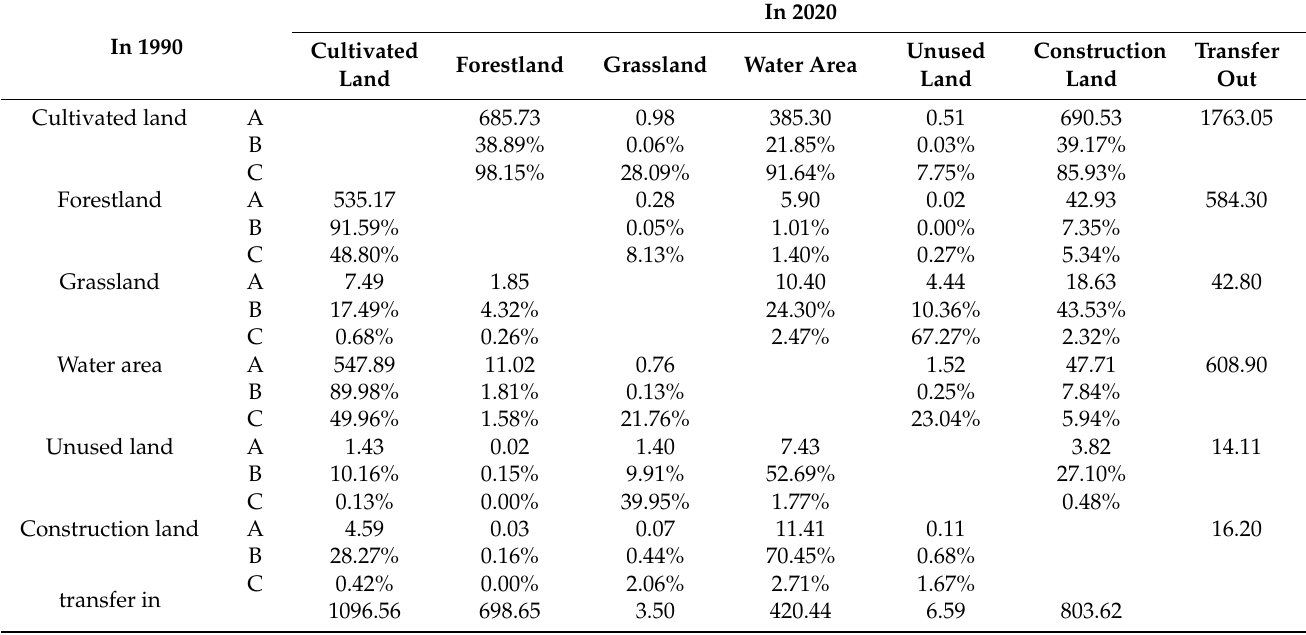
Table 3. Area and proportion of land conversion during